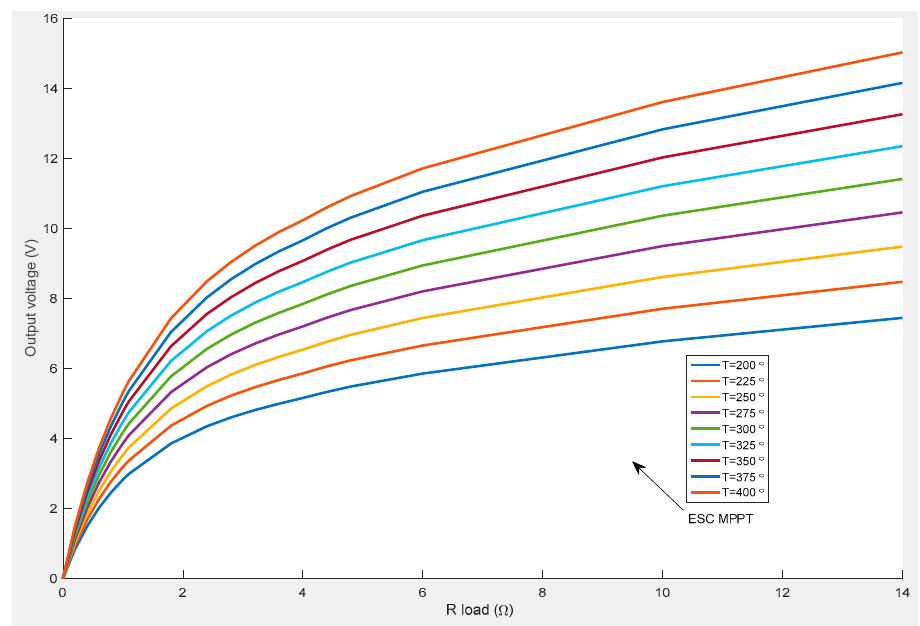
Figure 11. The output voltages of the ESC MPPT model for a single TEG.